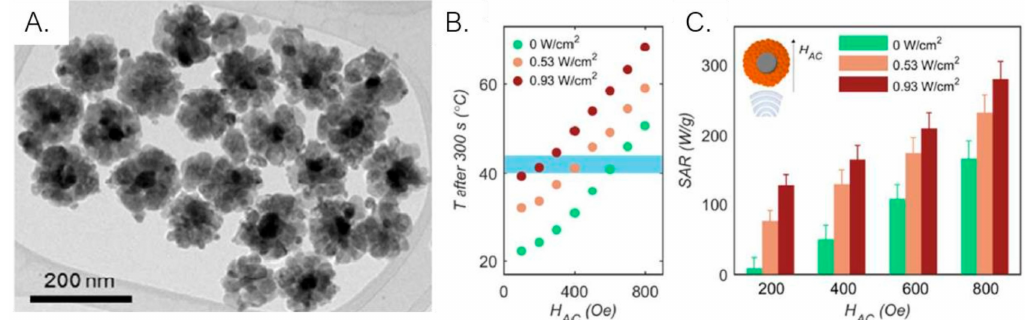
Figure 10. (A) TEM image of Ag / Fe 3 O 4 nanoflowers; ( B ) Temperature reached after 300 s of heating for di ff erent ac field intensities. The therapeutic temperature window (blue zone) is reached for lower magnetic field intensities when a laser is applied; ( C ) SAR values of Ag / Fe 3 O 4 nanoflowers as a function of AC field intensity (HAC) for di ff erent laser power densities. SAR values are the highest when a laser is simultaneously applied. Adapted from [162] with permission from American Chemical Society,